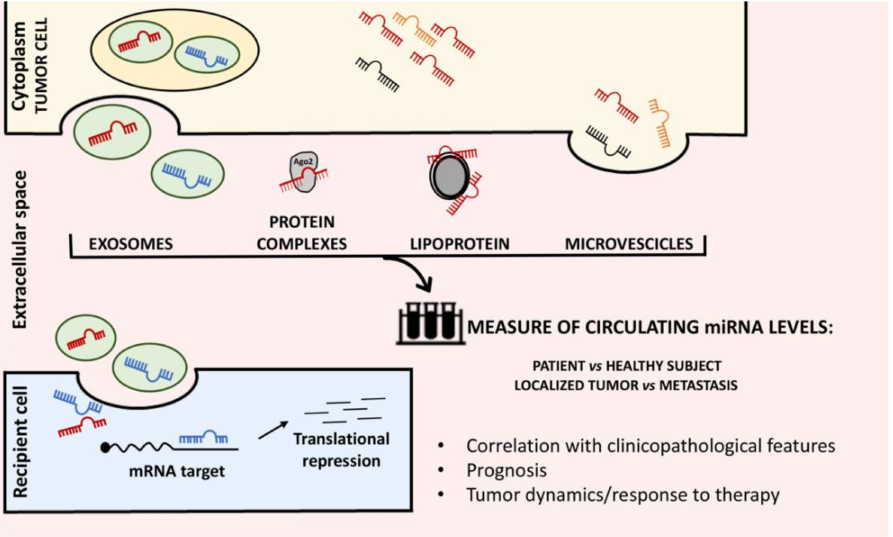
Figure 1. miRNAs release in the extracellular space. miRNAs can be released in the extracellular space through different ways, such as exosomes, by forming protein or lipoprotein complexes,